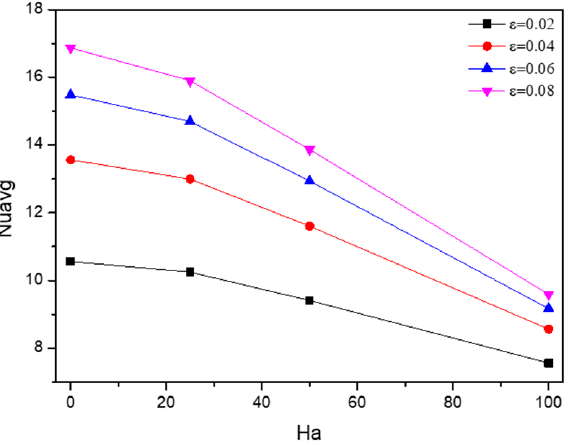
Figure 18. Total entropy as a function of Hartmann number (Ha) for various values of φ . Ra = 10 6 , Da = 0.01, and ε p = 0.4.